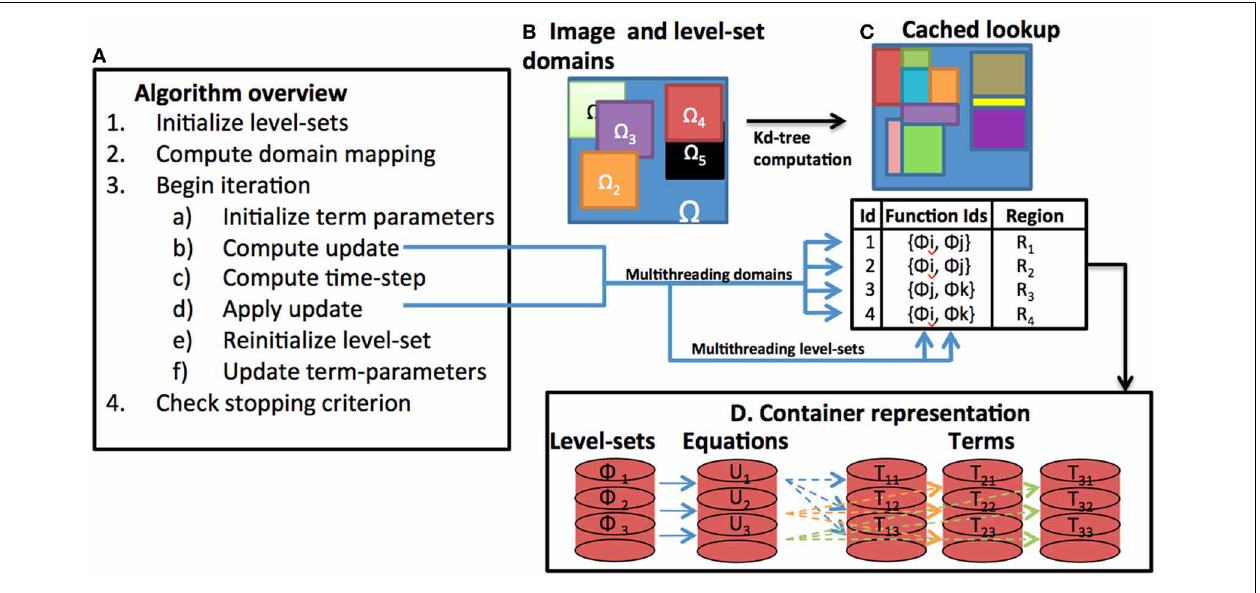
FIGURE 2 | Components of the level-set framework. (A) An overview of the basic level-set algorithm is provided. (B) Individual level-set domains are assumed to be subsets of the image domain. (C) The domain is partitioned into a label-map that specifies the interacting level-set ids and the